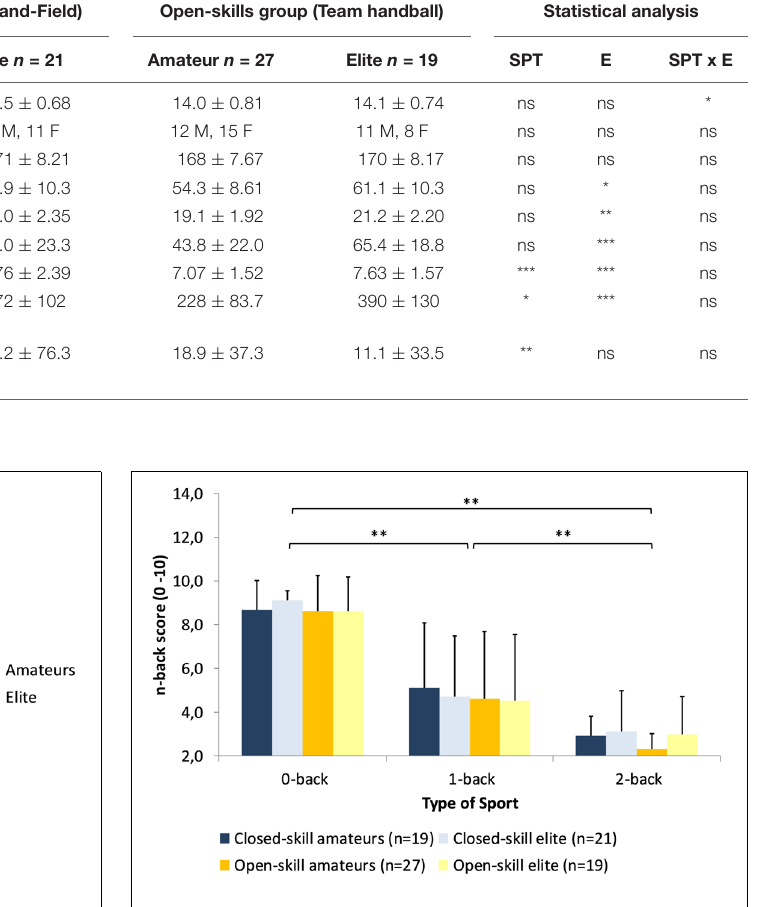
FIGURE 2 | Performance of the composite score on the n-back Task as a function of expertise and type of sport (** p < 0.01). level as independent variables controlled for sex, training experience, and training duration revealed a significant main effect for task difficulty, [ F (1,79) = 8.04, p = 0.006, η 2